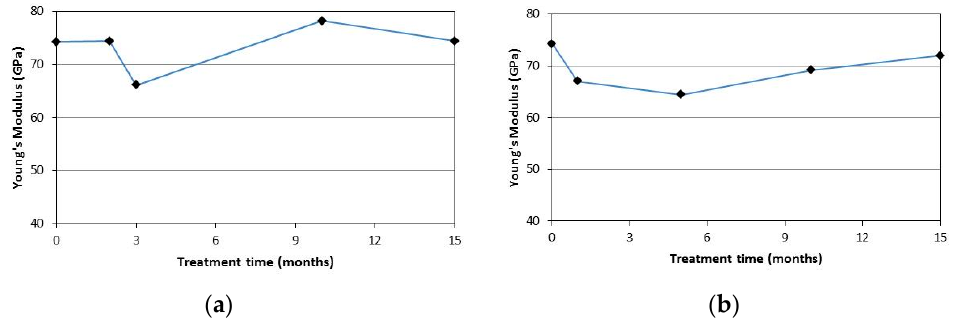
Figure 16. Young’s modulus vs. treatment time for SC-series: ( a ) NaCl solution; ( b ) deionized water.